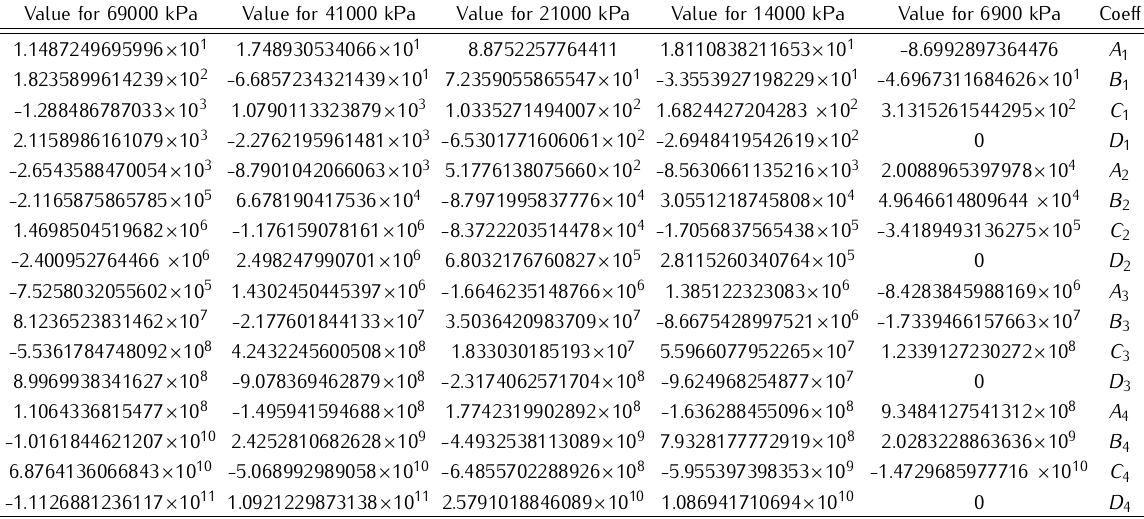
Table 1. Tuned coefficients used in equation 11-14 to correlate water content as a function of temperature at 6900, 14000 kPa (abs) , 21000, 41000 and 69000 kPa (abs).